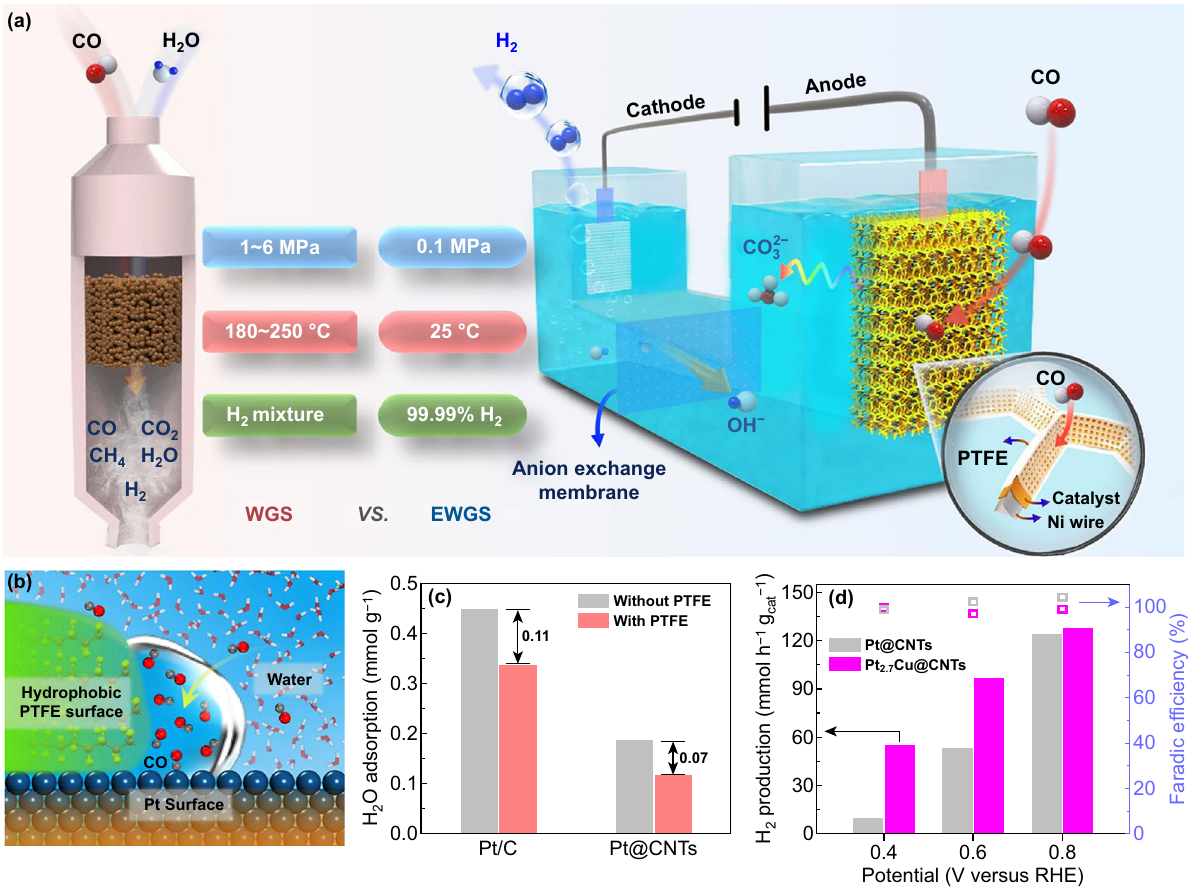
Fig. 16 a Schematic illustration of the EWGS process in comparison with the traditional WGS process, b schematic diagram of solid/liquid/gas interfaces on the PTFE-decorated Pt surface, c adsorption of H 2 O at 25 °C on Pt/C and Pt@CNTs with and without PTFE treatment detected by intelligent gravimetric analyzer, d the rate of H 2 production and FE on the cathode at different potentials with the Pt 2.7 Cu@CNTs and Pt@CNTs as the anode catalysts. Reproduced with permission from Ref. [205]. Copyright 2019 Springer